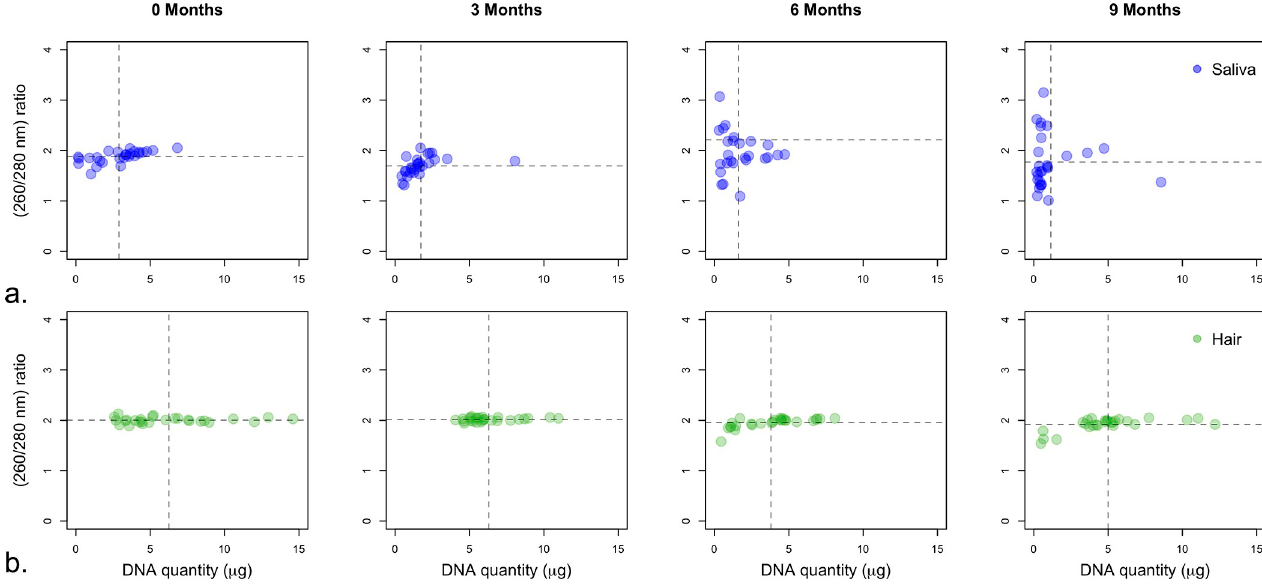
Fig 4. Quantity and purity of camel DNA extracted from saliva (buccal swabs) and tail-hair follicles over a nine-month period. DNA quantity ( μ g) on the x-axis and 260/280nm ratio on the y-axis over a nine-month period (0, 3, 6, and 9 month) extraction times, from (a) buccal swabs and (b) tail-hair follicles. Each circle corresponds to a single measurement (DNA quantity and 260/280nm ratio) from the first elution (100 μ l). The dashed horizontal line is the mean 260/280nm ratio and the dashed vertical line is the mean of the DNA quantities ( μ g).